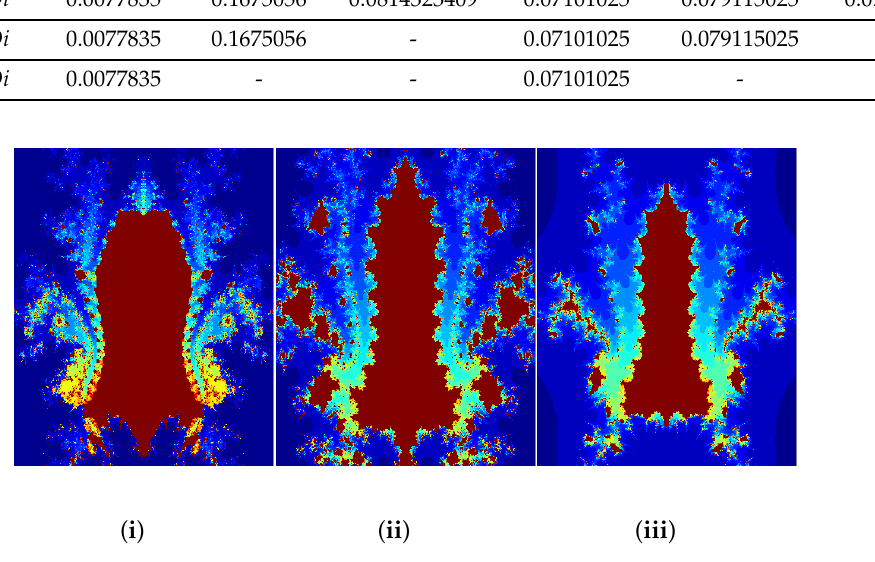
Figure 2. Cubic Julia sets in ( i ) Noor-orbit; ( ii ) Ishikawa-orbit; ( iii ) Mann-orbit. The parameters used in Figure 3 are as following in Table 3: Table 3. The parameters used in Figure